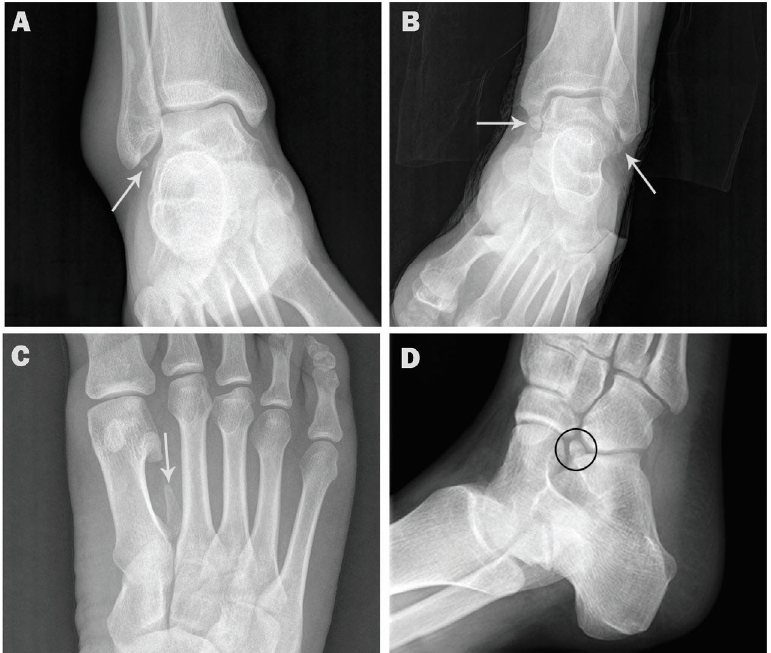
Figure 2. AP and oblique radiographs showing accessory ossicles. ( A ). AP ankle radiograph showing os subfibulare in a 53-year-old male (arrow). ( B ). AP ankle radiograph showing os subfibulare and os subtibiale in a 40-year-old male (arrows). ( C ). AP foot radiograph showing os intermetatarseum in 27-year-old female (arrow). ( D ). Oblique radiograph showing os calcaneus secundarius in 29-year-old female (circle).